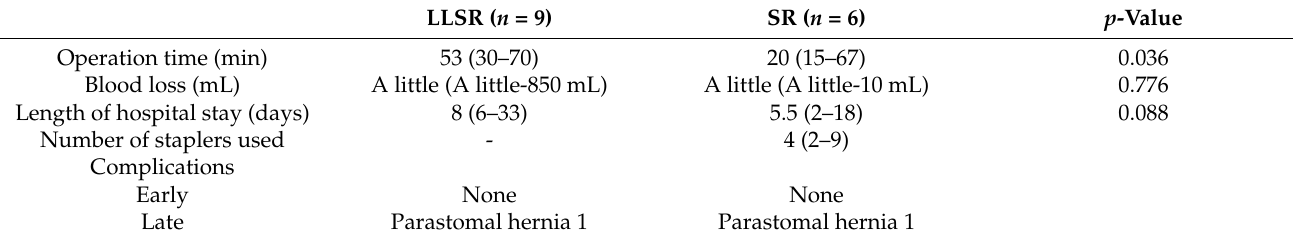
Table 3. Comparison of the surgical outcomes between LLSR and